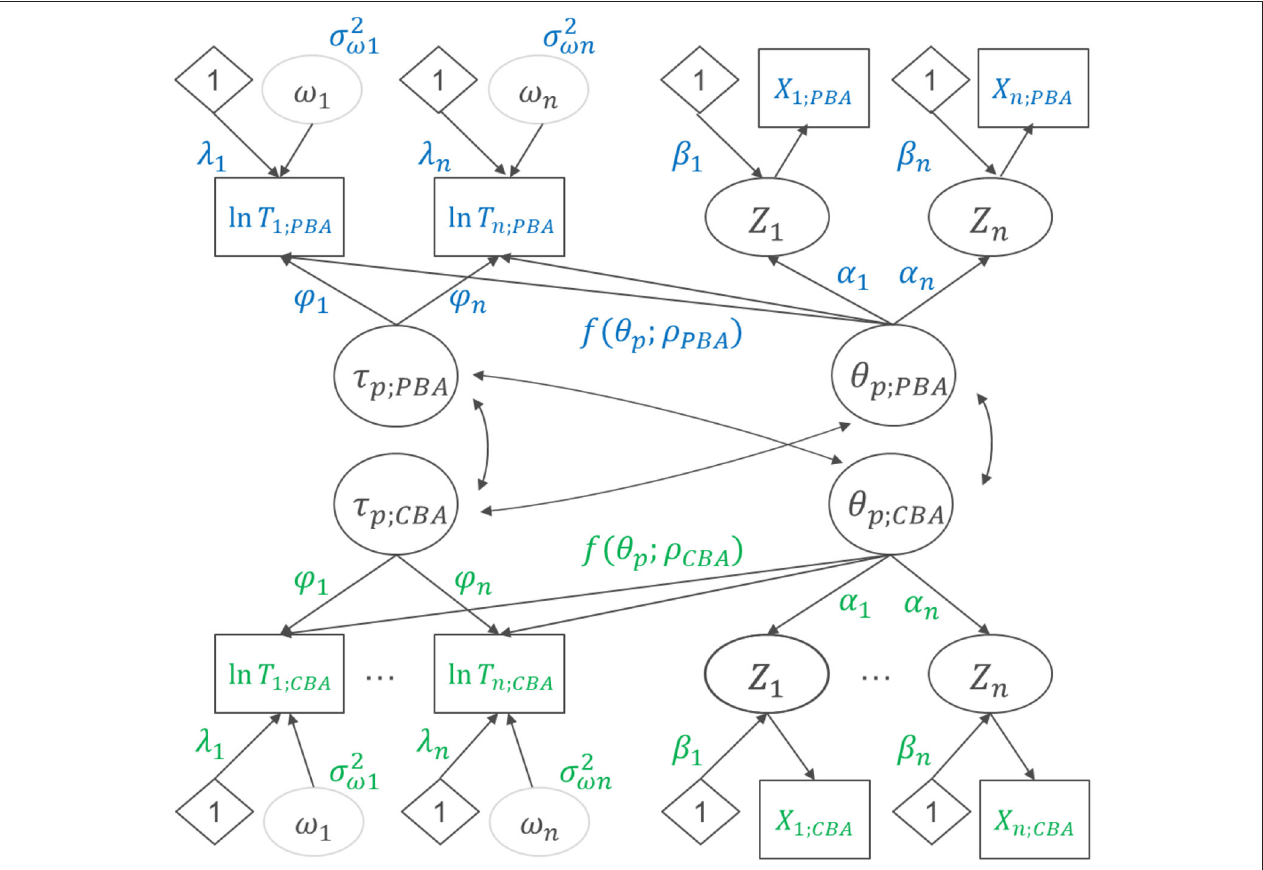
FIGURE 5 | B-GLIRT model for responses and response times gathered in a within-subject design with planned missing values in paper-based and computer-based